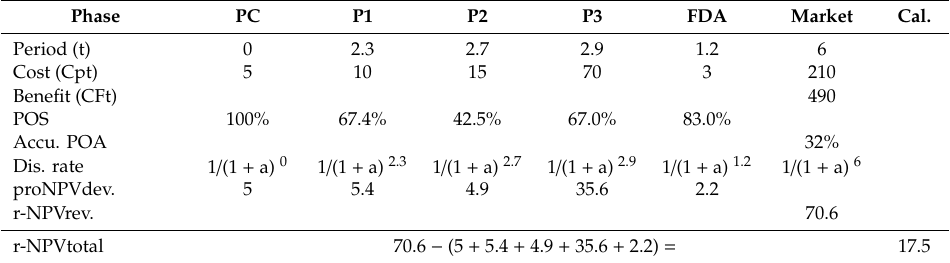
Table 18. r-NPV calculation case (new model for